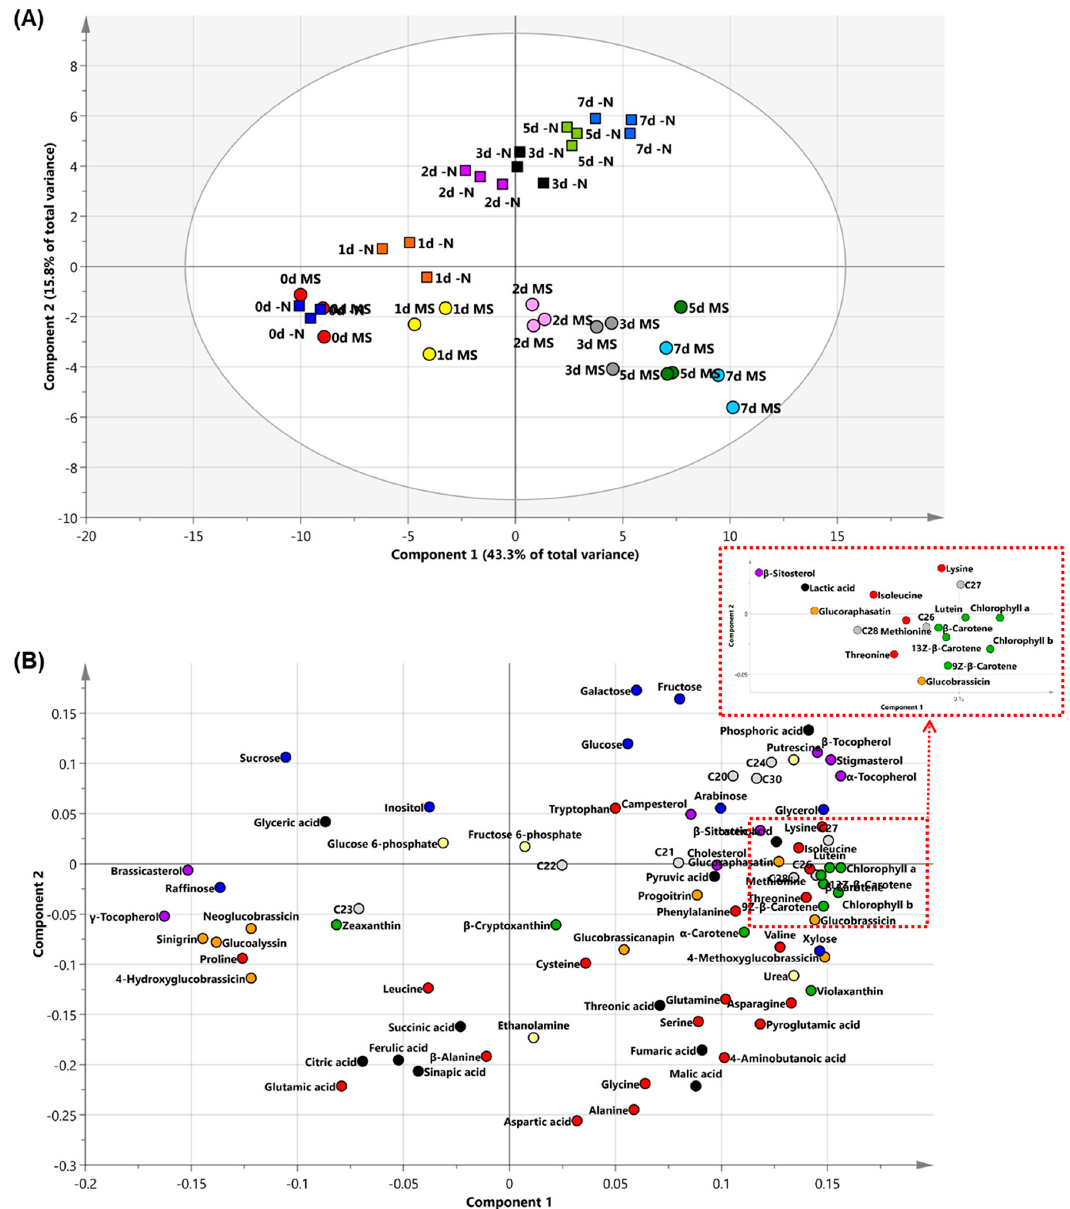
Figure 2. ( A ) Principal component analysis (PCA) score plots and ( B ) loading plots obtained from metabolite data of radish sprouts. PC1 and PC2 accounted for > 59.1% of the total variance. Amino acids, pigments, and glucosinolates are represented as red, green, and orange, respectively; sugars and sugar alcohols are represented as blue; organic acids and inorganic acids are represented as black; policosanols are represented as gray; tocopherols and phytosterols are represented as purple; and amines, amides, and sugar phosphates are represented as yellow. d, day after light incubation began; MS, radish sprouts grown under nitrogen sufficient conditions; –N, radish sprouts grown under nitrogen-deficient conditions; C20, Eicosanol; C21, Heneicosanol; C22, Docosanol; C23, Tricosanol; C24, Tetracosanol; C26, Hexacosanol; C27, Heptacosanol; C28, Octacosanol; C30, Triacontanol.